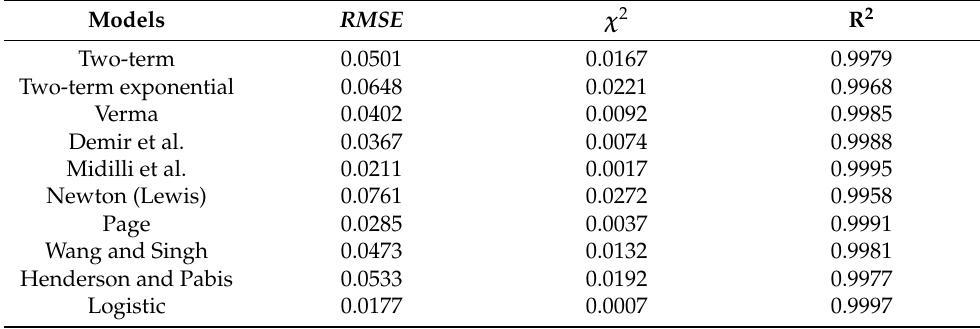
Table 2. Statistical analysis of mathematical modeling of kiwifruit slices drying